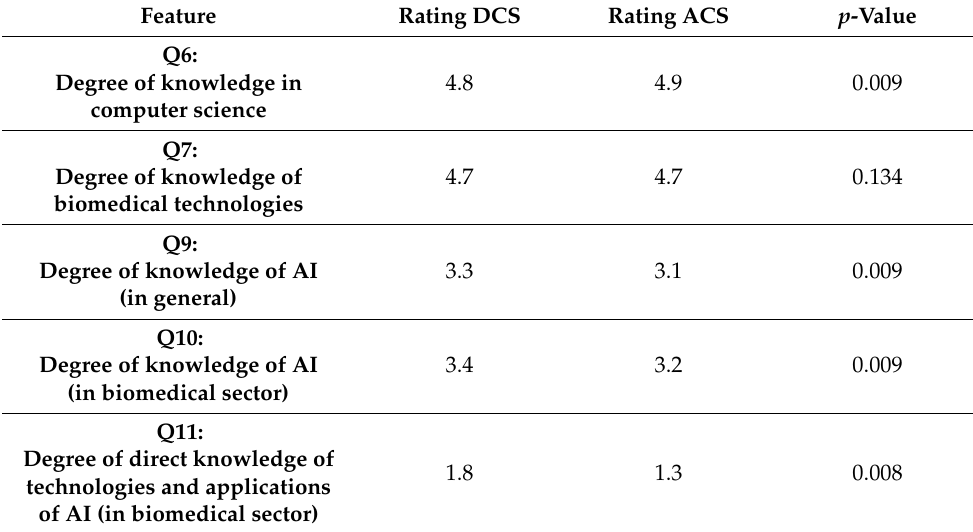
Table 2. Answers for the graded questions.